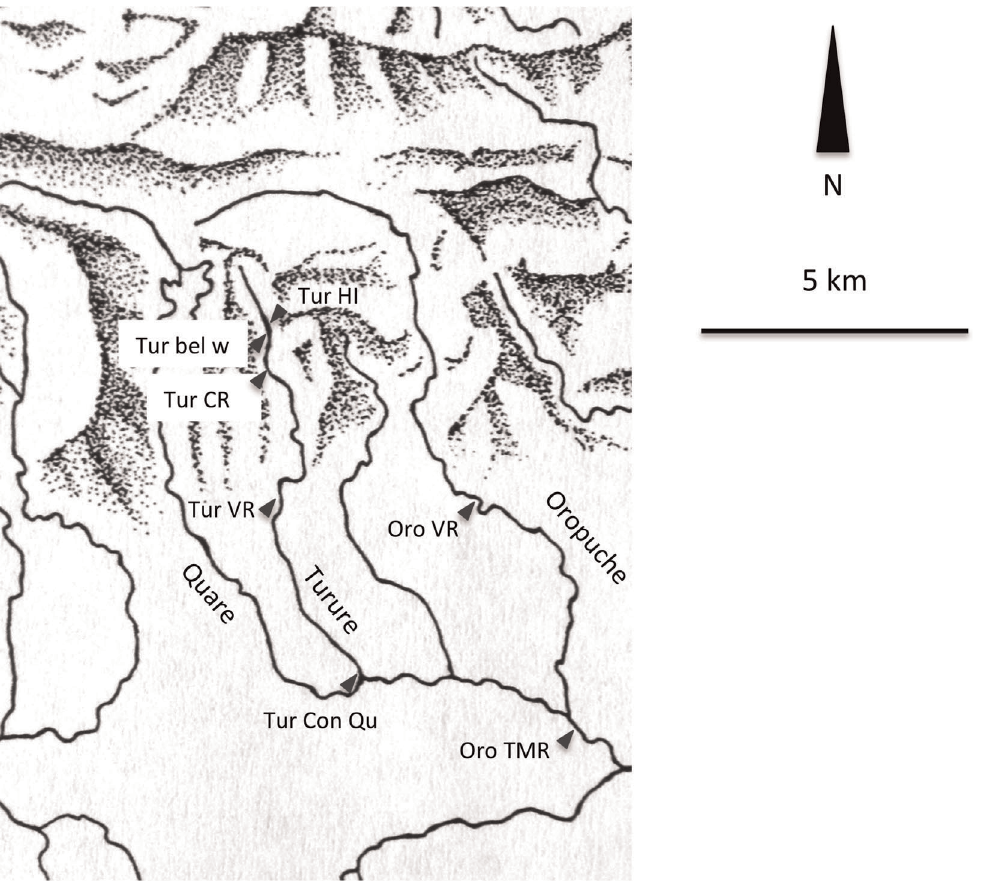
Figure 1. Collection sites at the Northern Mountain Range. Detail of the Northern Mountain Range map showing the Turure and Oropuche Rivers. Red arrows indicate the sites where fish collection took place. HI: Haskins’s introduction, bel w: below waterfall at introduction site, CB: Cumaca Bridge, VR: Valencia Road, Con Qu: Confluence with Quare, TMR: Toco Main Road. Not shown: Haskins’s source, Guanapo. doi:10.1371/journal.pone.0038404.g001 PLoS ONE |